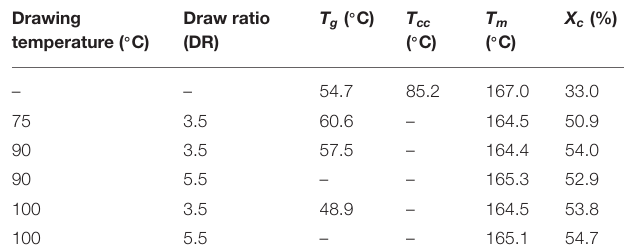
Frontiers in Materials |